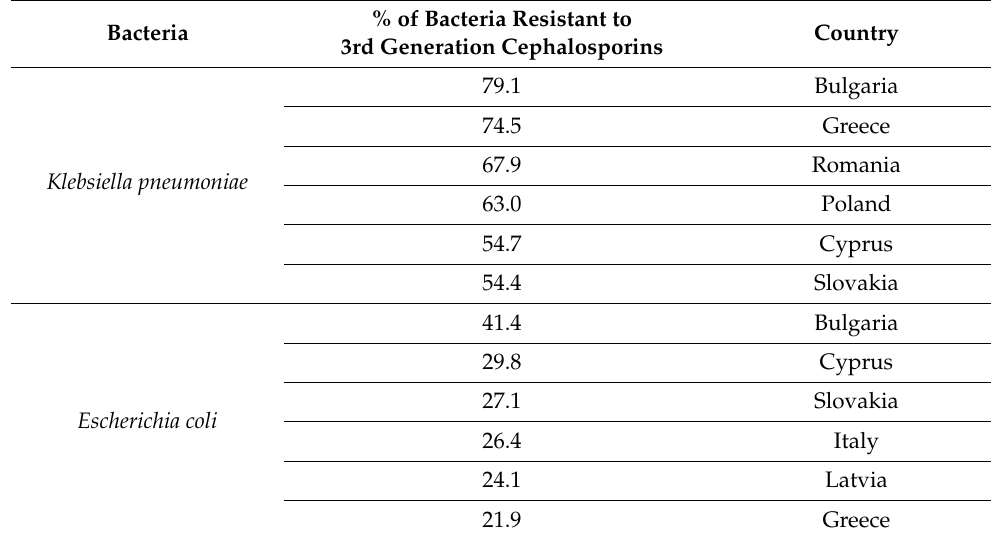
Table 1. European prevalence of critical priority bacteria that acquired 3rd generation cephalosporin- resistance